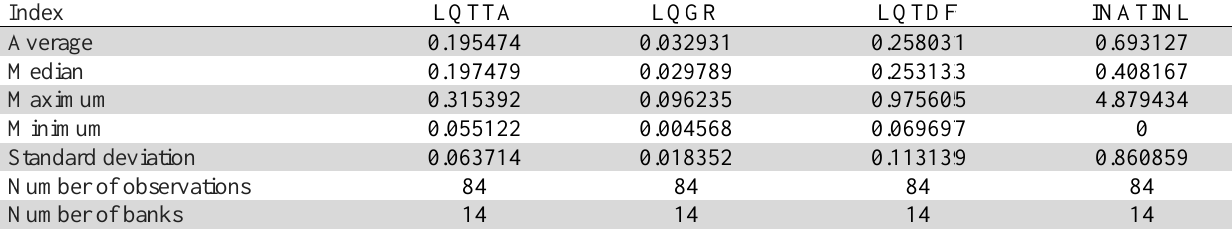
Statistical d Index Average Median Maximum Minimum Standard devia Number of ob Number of ban Statistical d ndex Average Median Maximum Minimum Standard deviation Number of observ Number of banks Based on th assets for al the highest